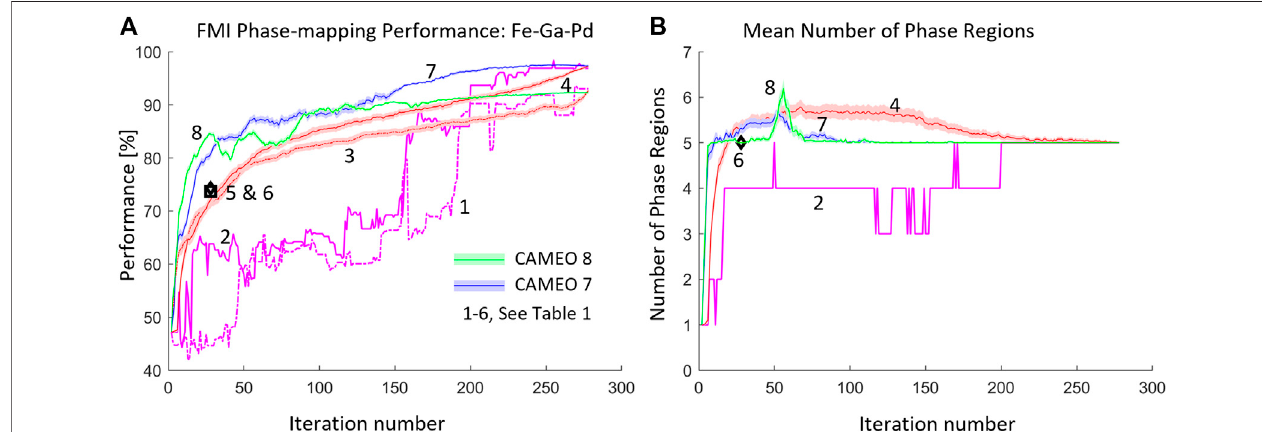
FIGURE1 | Fowlkes Mallow Index (FMI) phase-mapping performanceforFe-Ga-Pd material system. (A) FMI performancefor theset ofmethods listed in Table 2 . The average performance is indicated with 95% con fi dence intervals for methods 5 through 8 which were run 100 times with uniform randomly selected initial sample composition, (B) theaveragenumberofphaseregions(overthe100iterations)usedinphase-mappingfortheCAMEOphase-mappingmethods.Ifthemethoddoesnot appear here, the number of phase regions was fi xed at 5.